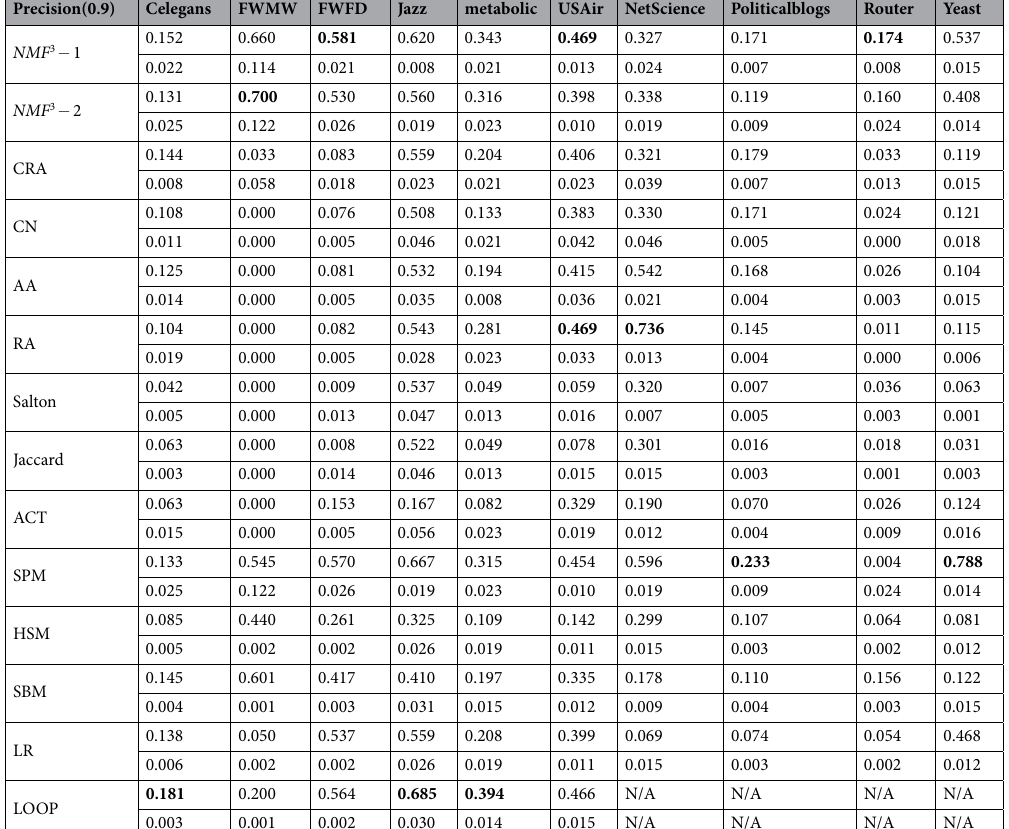
Table 2. Link prediction accuracy is measured by precision on the 10 real networks. We compared our methods ( NMF 3 − 1, NMF 3 − 2) with other methods on the 10 network data sets and the precision is returned with an average run of over 100 times. For each data set, the presented links are partitioned into training set (90%) and test set